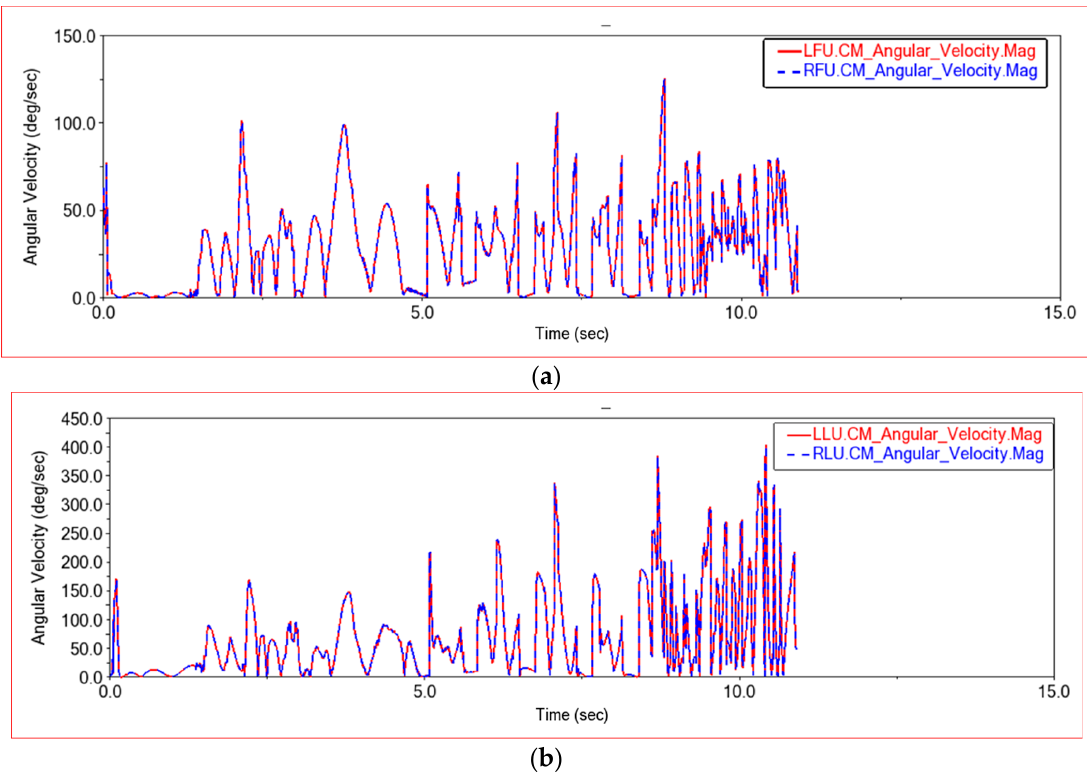
Figure 15. Angular speed comparison between front frame joint link and rear frame joint link. ( a ) Front frame joint link angular velocity change curve, LFU—Front frame upper left joint link, RFU—Front frame upper right joint link; ( b ) Rear frame joint link angular velocity change curve, LLU—Rear frame upper left joint link, RLU—Rear frame upper right joint link.